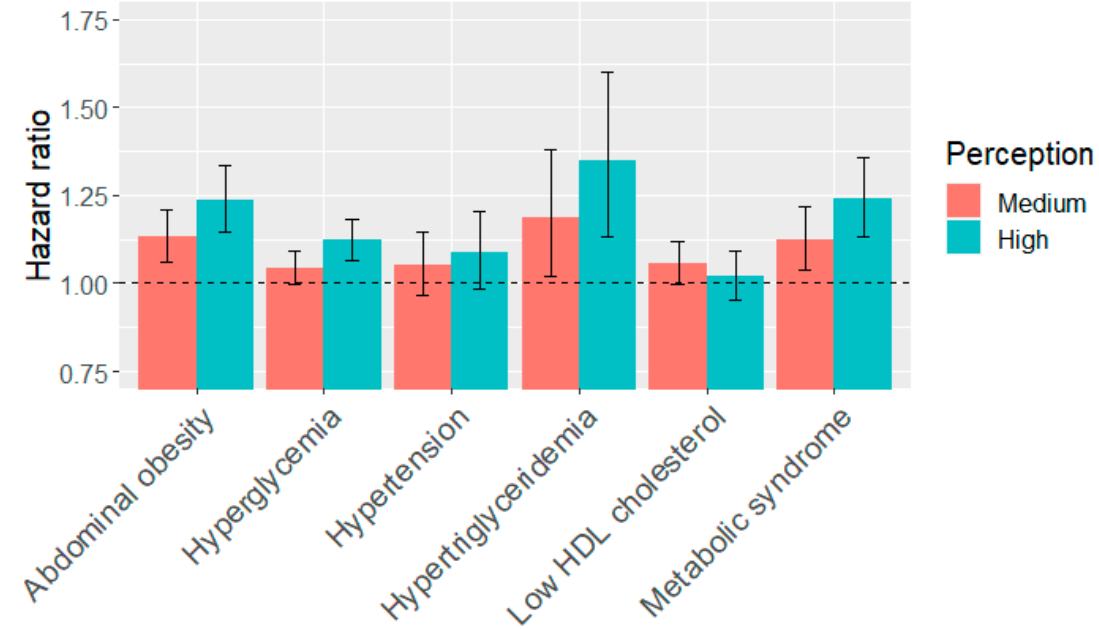
Figure 4. E ff ect estimates (and 95% confidence intervals) from multivariate Cox models of metabolic syndrome and its components.